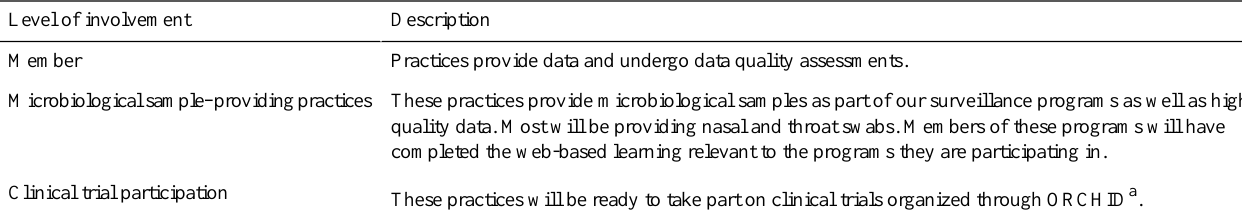
Table 3. Levels of involvement for general practices in the Oxford RCGP RSC and ORCHID